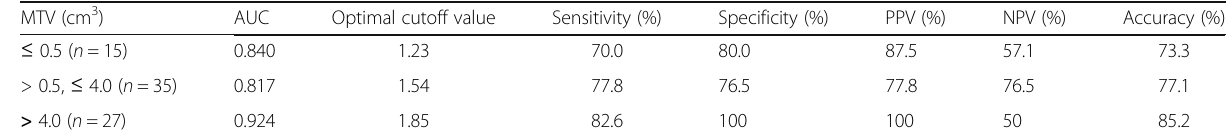
Table 2 Different cutoff values for tumor to normal tissue ratio according to metabolic tumor volume